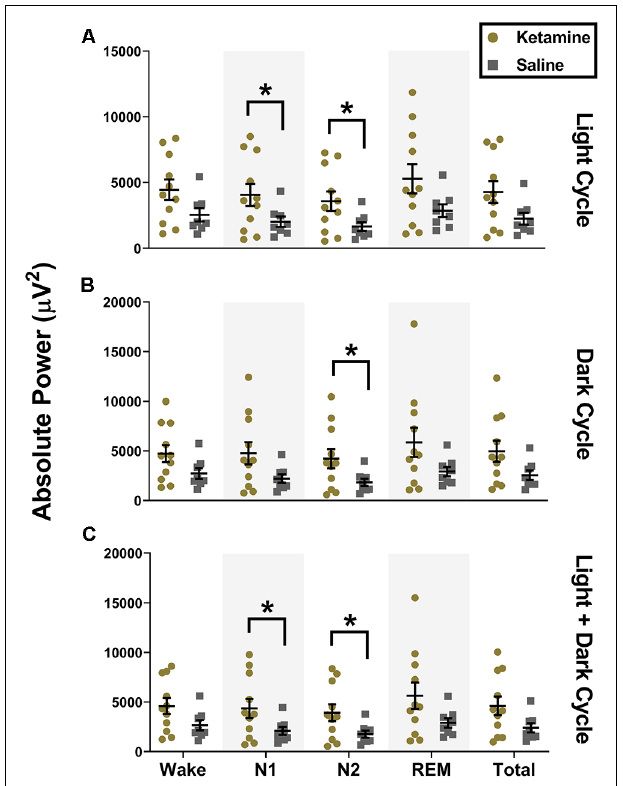
FIGURE 4 | Neonatal ketamine exposure increases subicular high gamma power during N1 and N2 of the light cycle. (A) Neonatal ketamine exposure resulted in a significant increase in power spectra in the high gamma frequency range during N1 and N2 of the light cycle ( P = 0.043 and P = 0.040 for N1 and N2, respectively). However, also during the light cycle, there were no changes in high gamma oscillations during Wake ( P = 0.109), REM ( P = 0.078), or across total recording period ( P = 0.066). (B) During the dark cycle, there were no changes in high gamma power during N1 ( P = 0. 083) or N2 ( P = 0.073). There were also no differences in high gamma oscillations during Wake ( P = 0.163), REM ( P = 0.099), or across total recording period ( P = 0.117). (C) When light and dark cycles were combined, changes in high gamma during N1 ( P = 0.083) and N2 ( P = 0.051) were not statistically significant. Consistent with results in the light and dark cycle separately, we did not note any changes in high gamma oscillations during Wake ( P = 0.144), REM ( P = 0.090), and across the total recording period when both cycles were combined ( P = 0.087; * P <